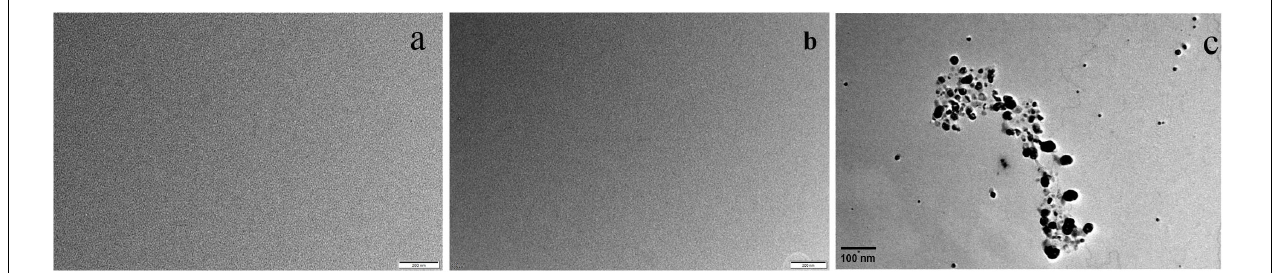
FIGURE 6 | Transmission electron micrographs for (a) Ag(I), (b) Ery − , and (c) the products of the reaction for Ery and Ag(I).